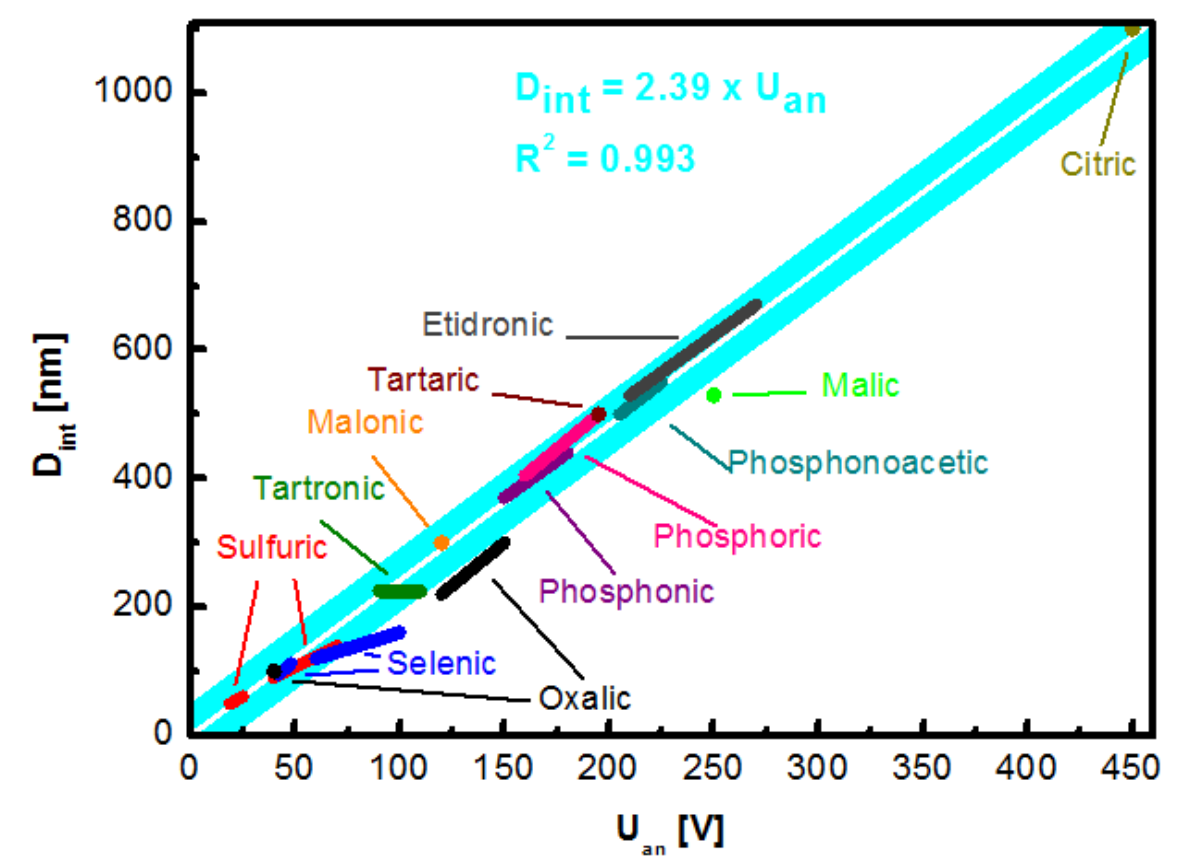
Figure 4. Linear relationship between anodization potential and interpore distance for self-ordered NAA formed during anodization in various electrolytes: Sulfuric, selenic, oxalic, tartronic, malonic, phosphonic, phosphoric, tartaric, phosphonoacetic, etidronic, malic, and citric acids.